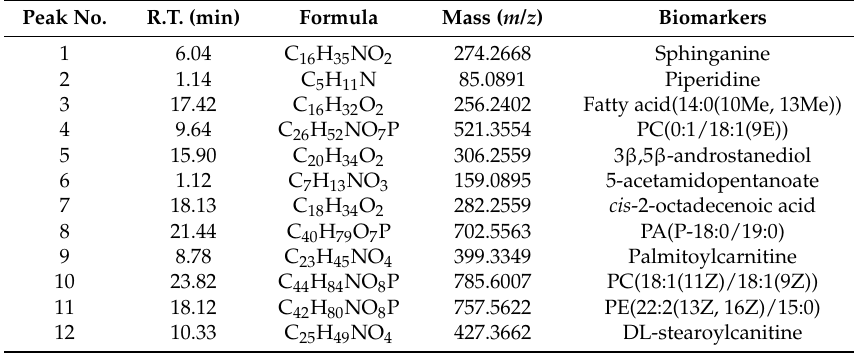
Table 2. Identification results of the main potential biomarker